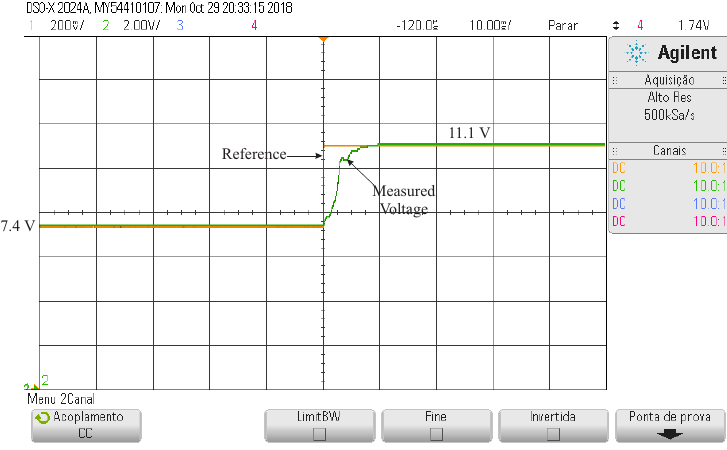
Figure 10. Response of the SMPI for a voltage step